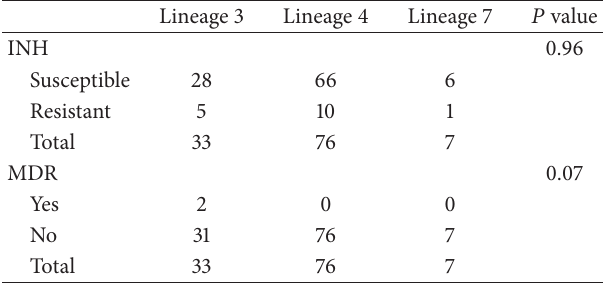
Table 3: Association of INH resistance or multidrug resistance with